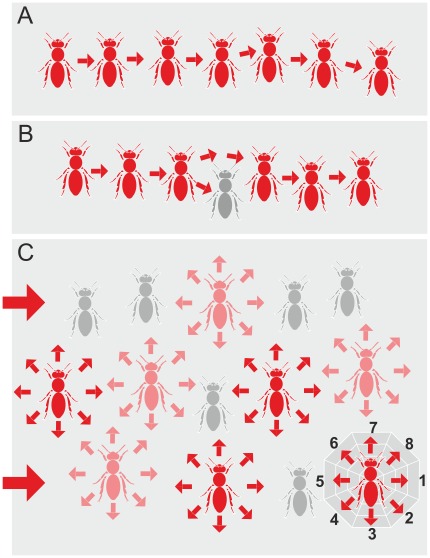
Schematic of bucket bridging during shimmering and the aspects of linearity and continuity in propagation.(A) Linear and continuous transmittance: Information is transferred (symbolized by red arrows) from one agent bee to the next member of the chain. (B) Linear but discontinuous transmittance: one agent bee in the chain fails to act as transmitter but information is by-passed to the next agent in the chain. (C) Schema of a sample wave which spreads from left to right (dirWAV = fromLtoR) explaining the complex situation of the bee curtain of A. dorsata during shimmering, with non-linearity and discontinuity of transmittance; three types of agent bees are noted: red, strong transmittance corresponding to wave strength levels of cws>2; light red, weak transmittance corresponding to wave strength levels of 1≥cws≤2; grey, no transmittance corresponding to a wave strength level of cws = 0 (these bees were detected as agent bees but not further considered in the evaluation). The arrows signify that information is transmitted from any abdomen-flipping agent bee into all eight neighbourhood sectors (for definition of dir Nh, see sketch at the bottom right, see Table 1 for definitions of angular sectors).